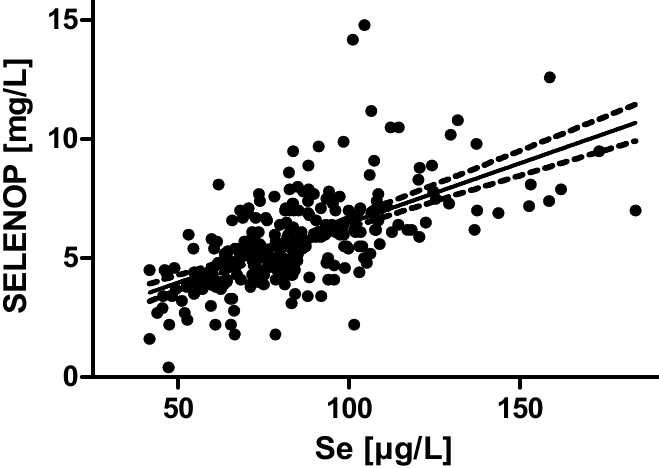
Figure 2. Correlation analysis between SELENOP and Se concentrations. A subset of 284 plasma samples was analyzed for both SELENOP and Se concentrations. The two biomarkers of Se status correlate strongly across the study cohort, indicative of sub-optimal Se intake (Spearman’s correlation coe ffi cient; r =